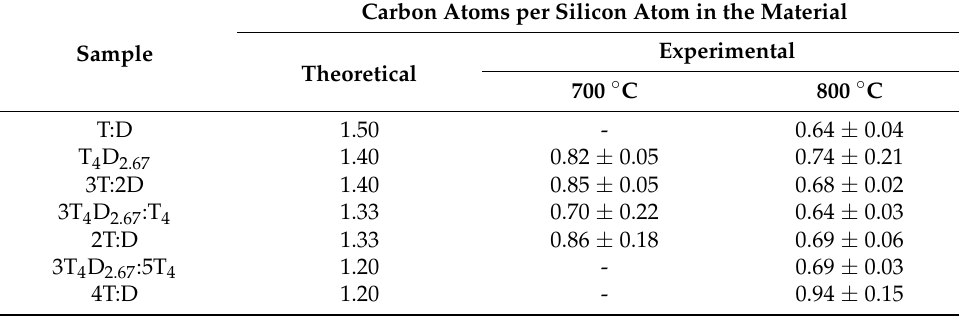
Table 2. Carbon atoms per silicon atom in materials after